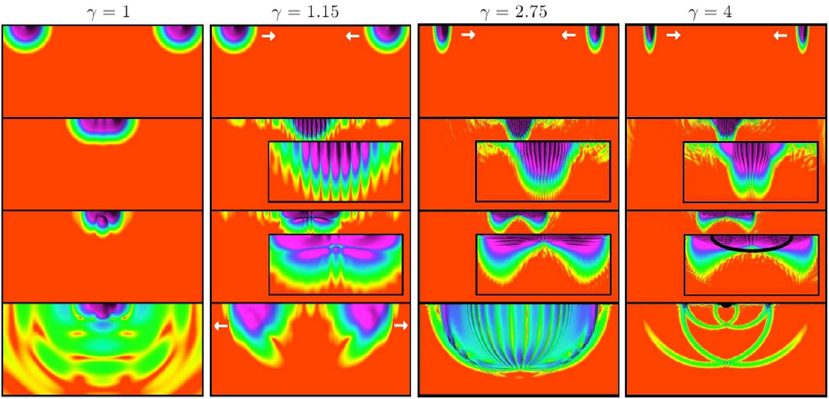
Fig. 25 Evolutions of the head-on collisions of identical boson stars boosted toward each other with initial Lorentz factors γ as indicated. Time flows downward within each column and the top edge displays the axis of symmetry. The color-scale indicates the value of | φ | . In the middle frames one sees the interference pattern characteristic of high kinetic energy BS collisions (as mentioned in Fig. 1). In the last column on the right, the collision produces a BH with apparent horizon indicated by the black oval in the third frame. Reprinted with permission from Choptuik and Pretorius (2010); copyright by